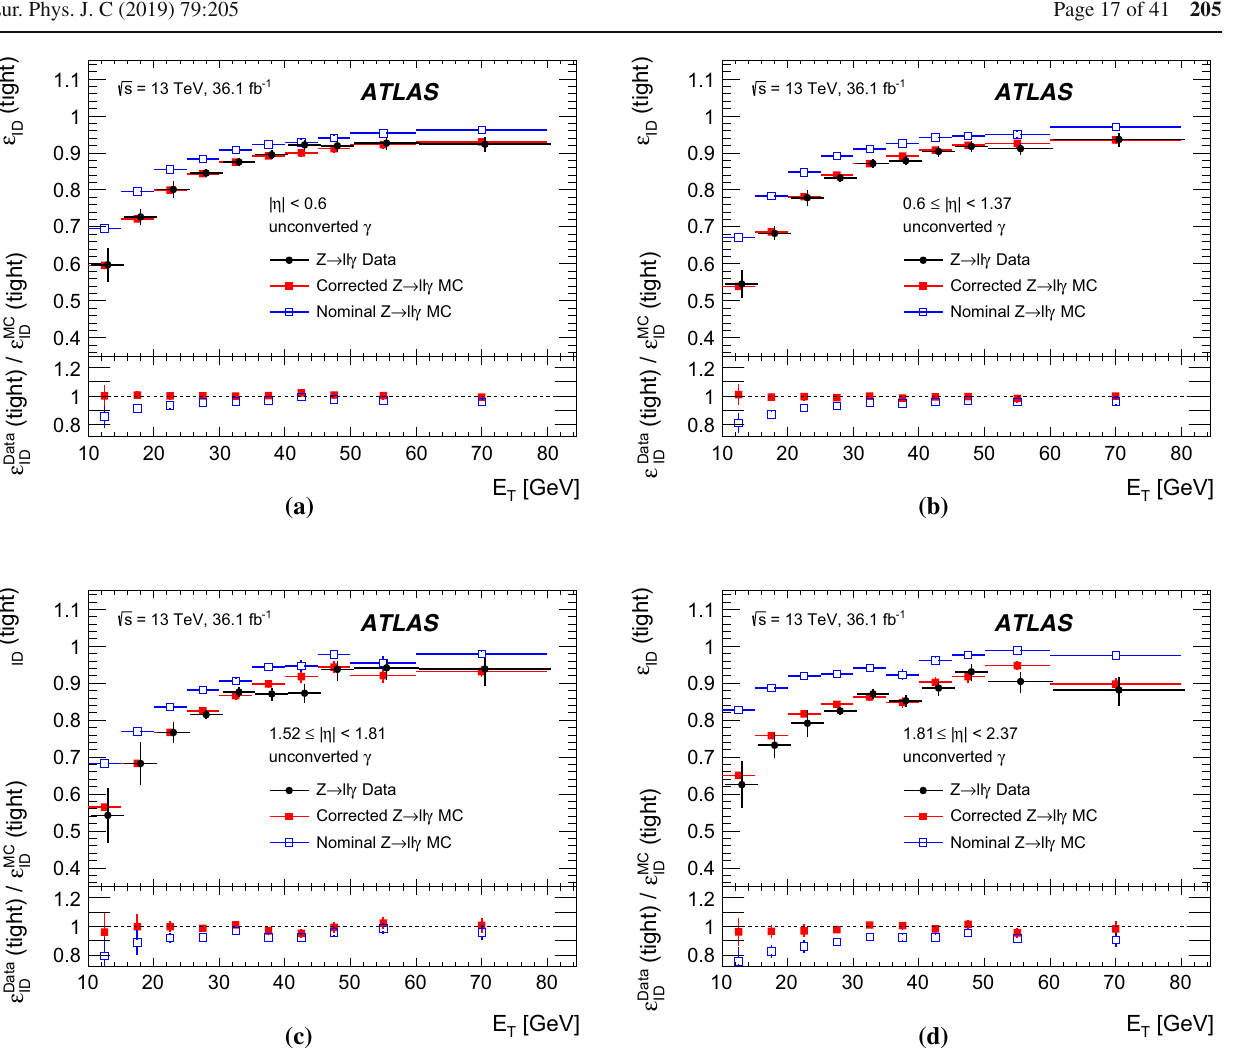
1 . 81 ≤ | η | < 2 . 37. Predictions are shown for both the nominal simula- tion and with the corrections described in Sect. 4.1. The bottom panels show the ratio of the data-driven values to the MC predictions (referred to as efficiency corrections in the